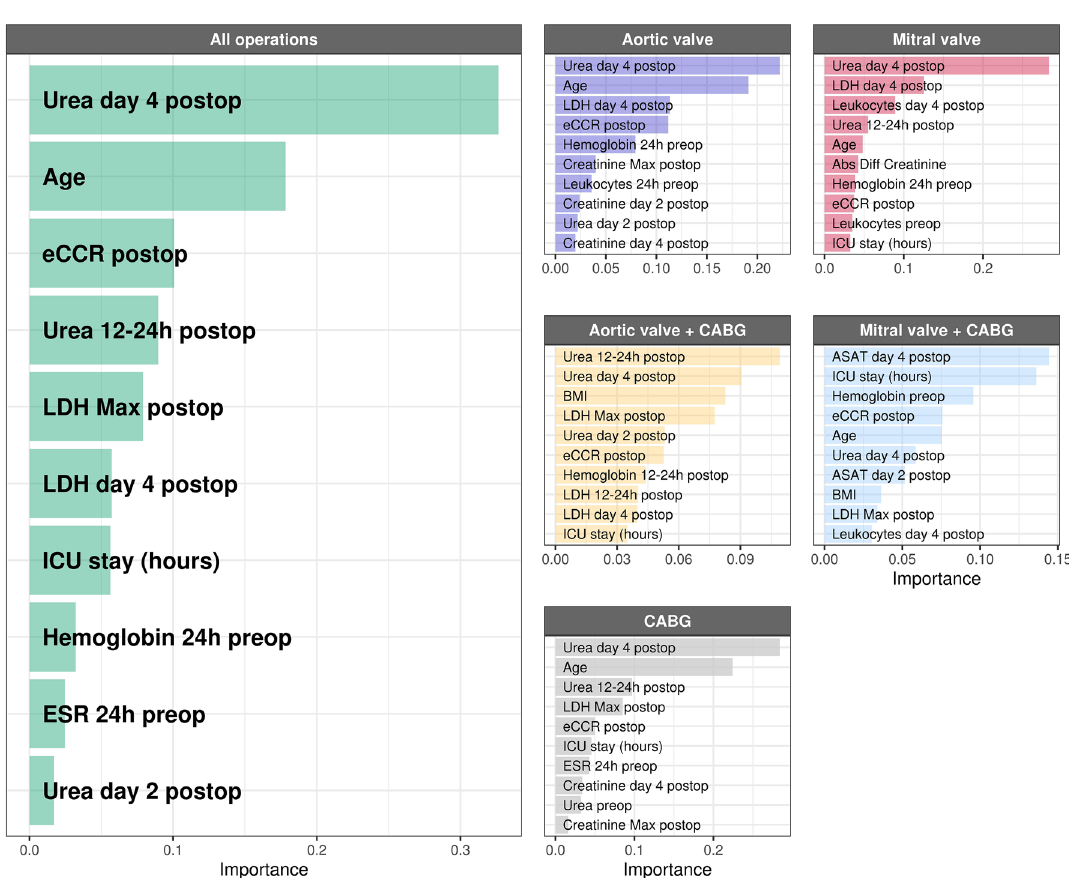
Figure 3. Top ten predictor variables for all types of operations combined. Variable coefficients indicate how much each parameter contributes to the outcome. eCCR estimated creatinine clearance, LDH lactate dehydrogenase, ESR erythrocyte sedimentation rate, ICU intensive care unit, ASAT aspartate transaminase, BMI body mass